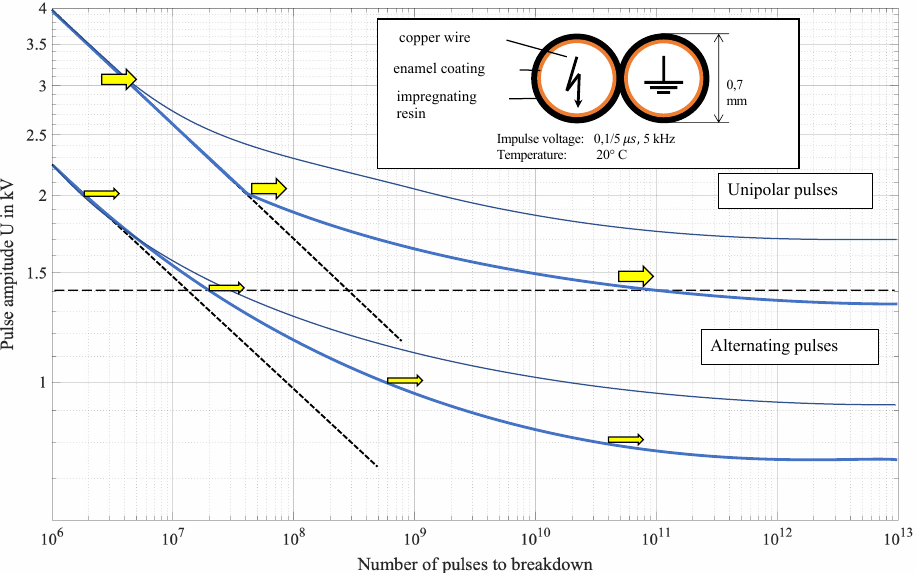
Figure 7. Relationship between partial discharge and breakdown behavior of typical turn insulations; figure extrapolated from experimental data of the work conducted by Kaufhold et al.